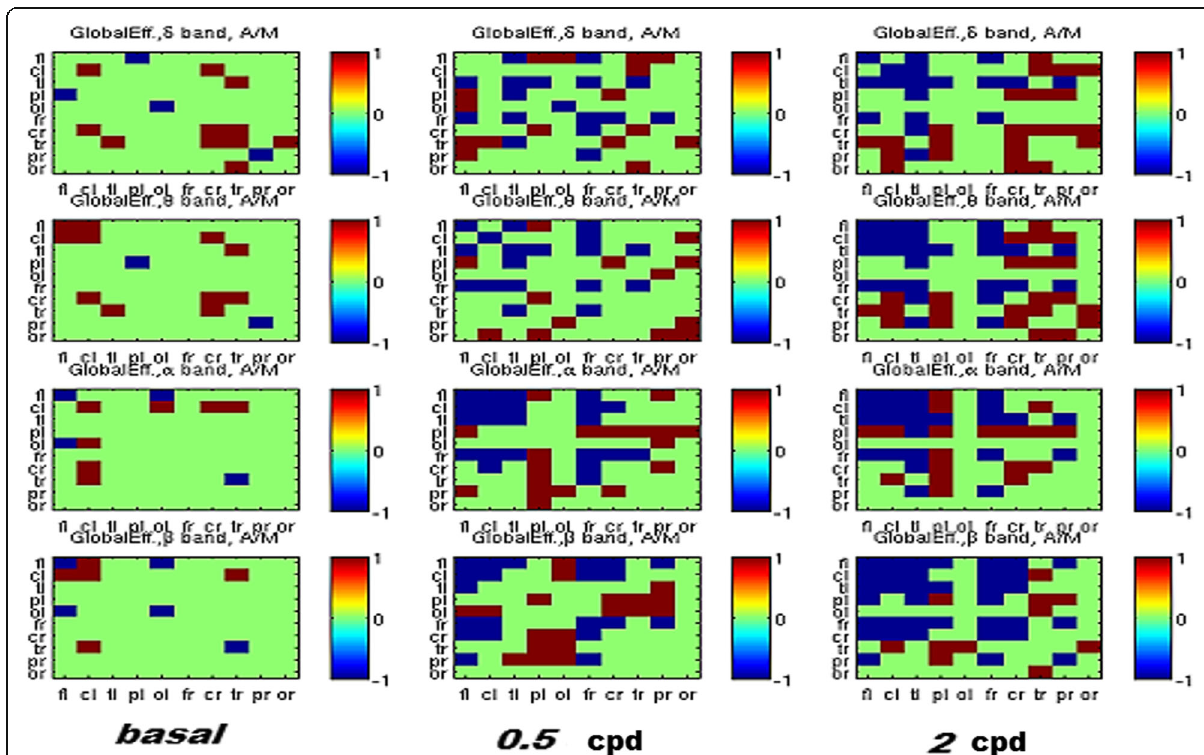
Fig. 7 Comparison of global efficiency in Migraine with aura (MA) and Migraine Without Aura populations: the matrix elements in red (+1) account for larger values in MWA, while those in blue ( − 1) account for larger values od MWoA. Green cells mean no distinction. (further data on analysis are available in the Additional file 1: section, chapter 5.6.2) The EEG electrodes were merged into 4 main scalp zones: fl, frontal, cl, central, tl, temporal, pl, parietal, ol,